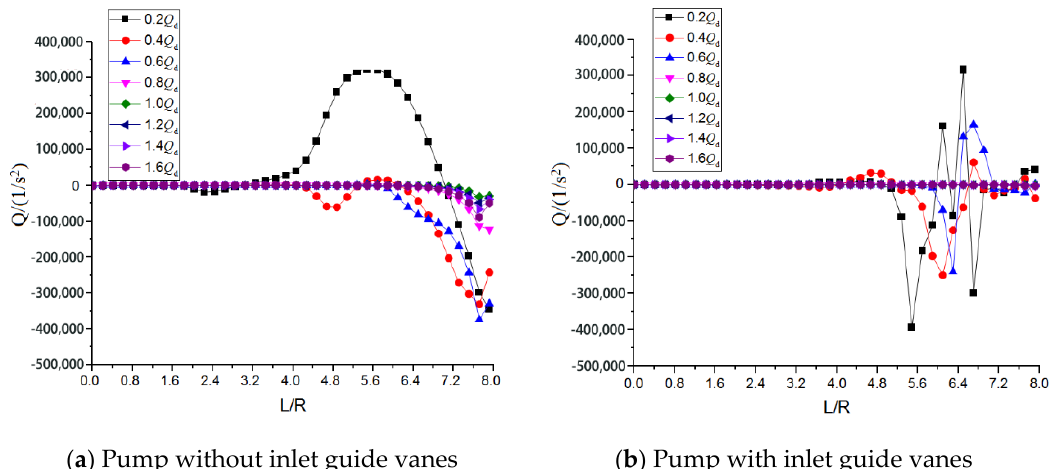
Figure 6. Numerical distribution of Q criteria for inlet and outlet sections with or without inlet guide vanes.